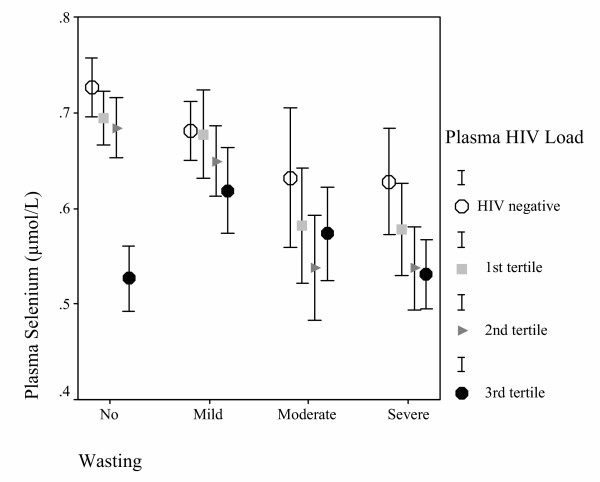
Mean plasma selenium concentrations with 95% C.I. are depicted by severity of wasting and plasma HIV load. Among not-wasted and severely wasted adults, mean plasma selenium concentrations significantly decrease with the increase of plasma HIV load (P = 0.0001 and P = 0.03, respectively). This trend did not reach significance among those with mild and moderate wasting. Among the HIV negative adults, and those in the 1st and 2nd tertile of plasma HIV load, mean plasma selenium concentrations significantly decreased with the increasing severity of wasting (P = 0.02, P = 0.008 and P = 0.0001, respectively). This trend did not reach significance among those in the 3rd tertile of plasma HIV load.